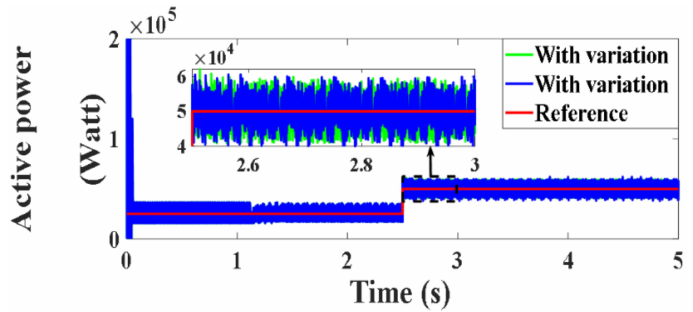
Figure 121. Active power under PVC (Watt).